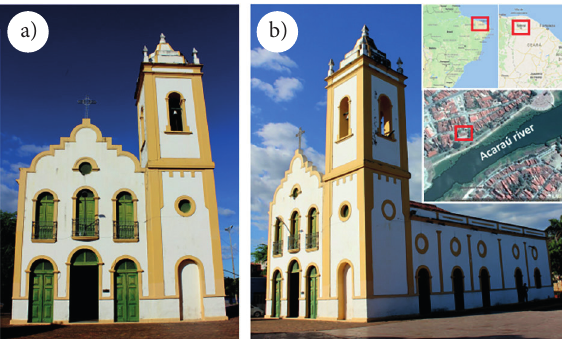
Fig. 2. Nossa Senhora das Dores Church: a) main façade